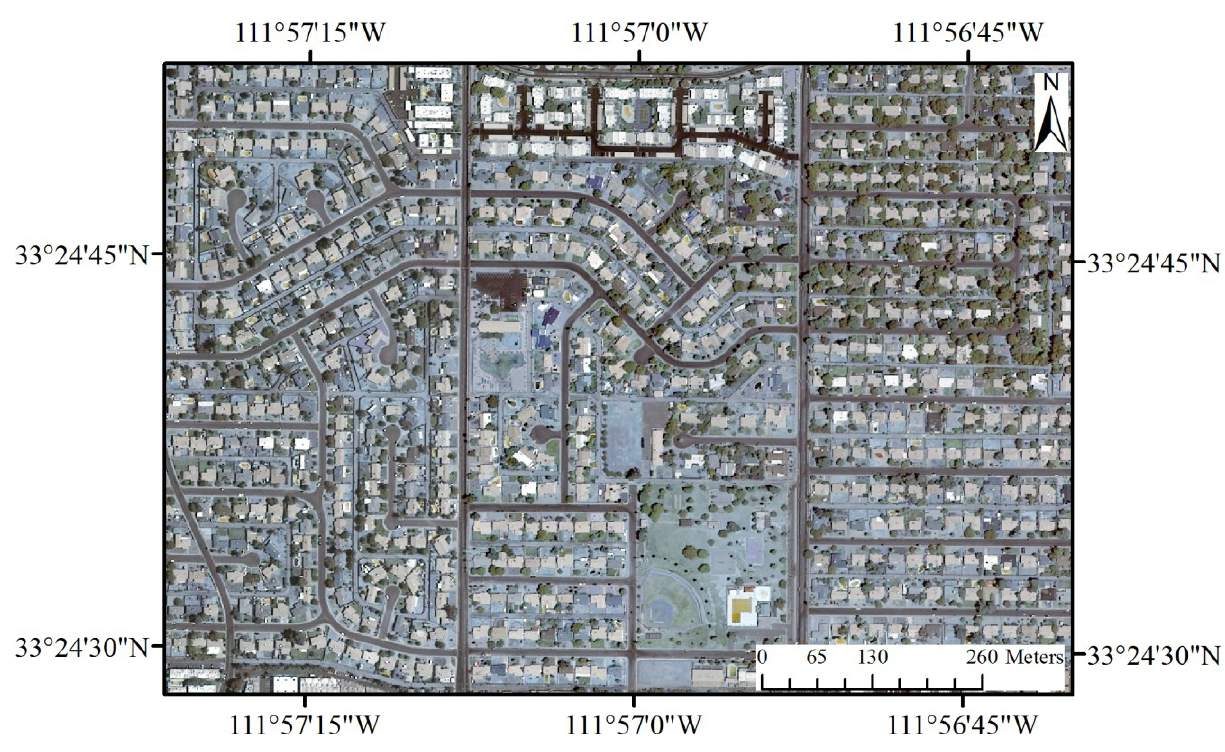
Figure 4. Raw MASTER night time imagery.